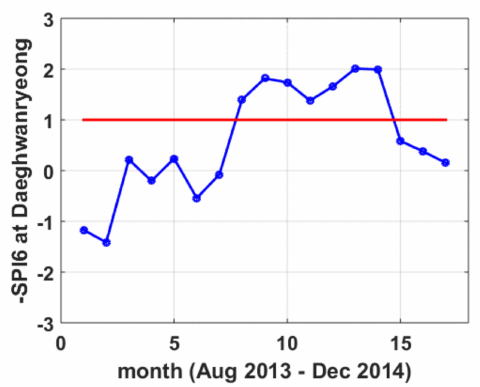
Figure 7. SPI6 time series for a drought event at Daeghwanryeong site.